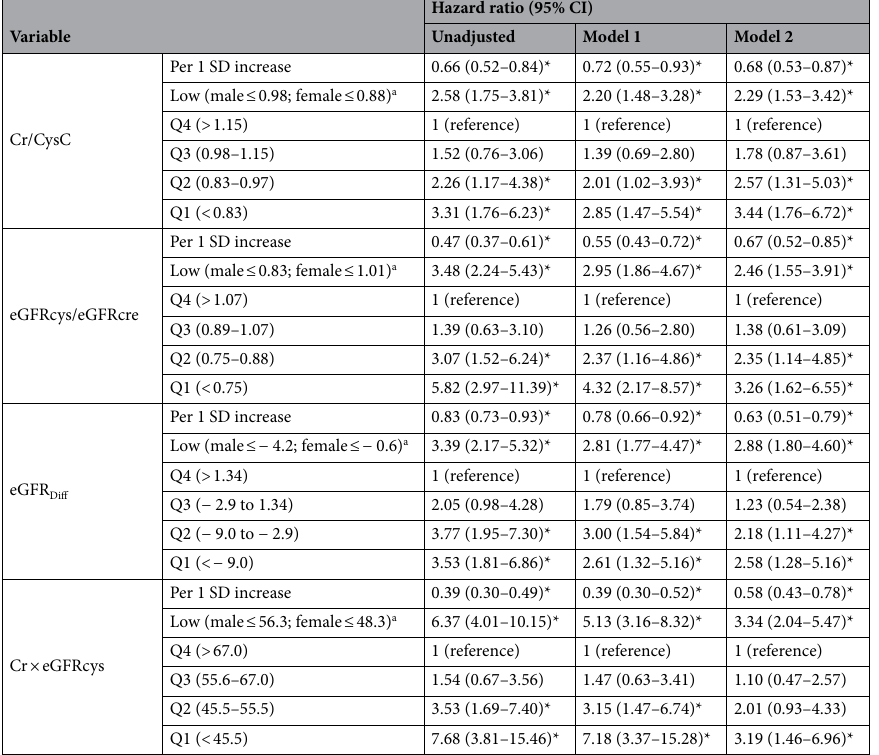
Table 4. Hazard ratios for death according to the sarcopenia indices, analyzed as a continuous or categorical variable. Model 1: adjusted for age, sex, BMI, DM, CV disease, and malignancy. Model 2: Model 1 + hemoglobin, albumin, TCH, BUN, and eGFRcys. CI confidence interval, SD standard deviation, Q quartile. *p < 0.05 was considered statistically significant. a Normal group as